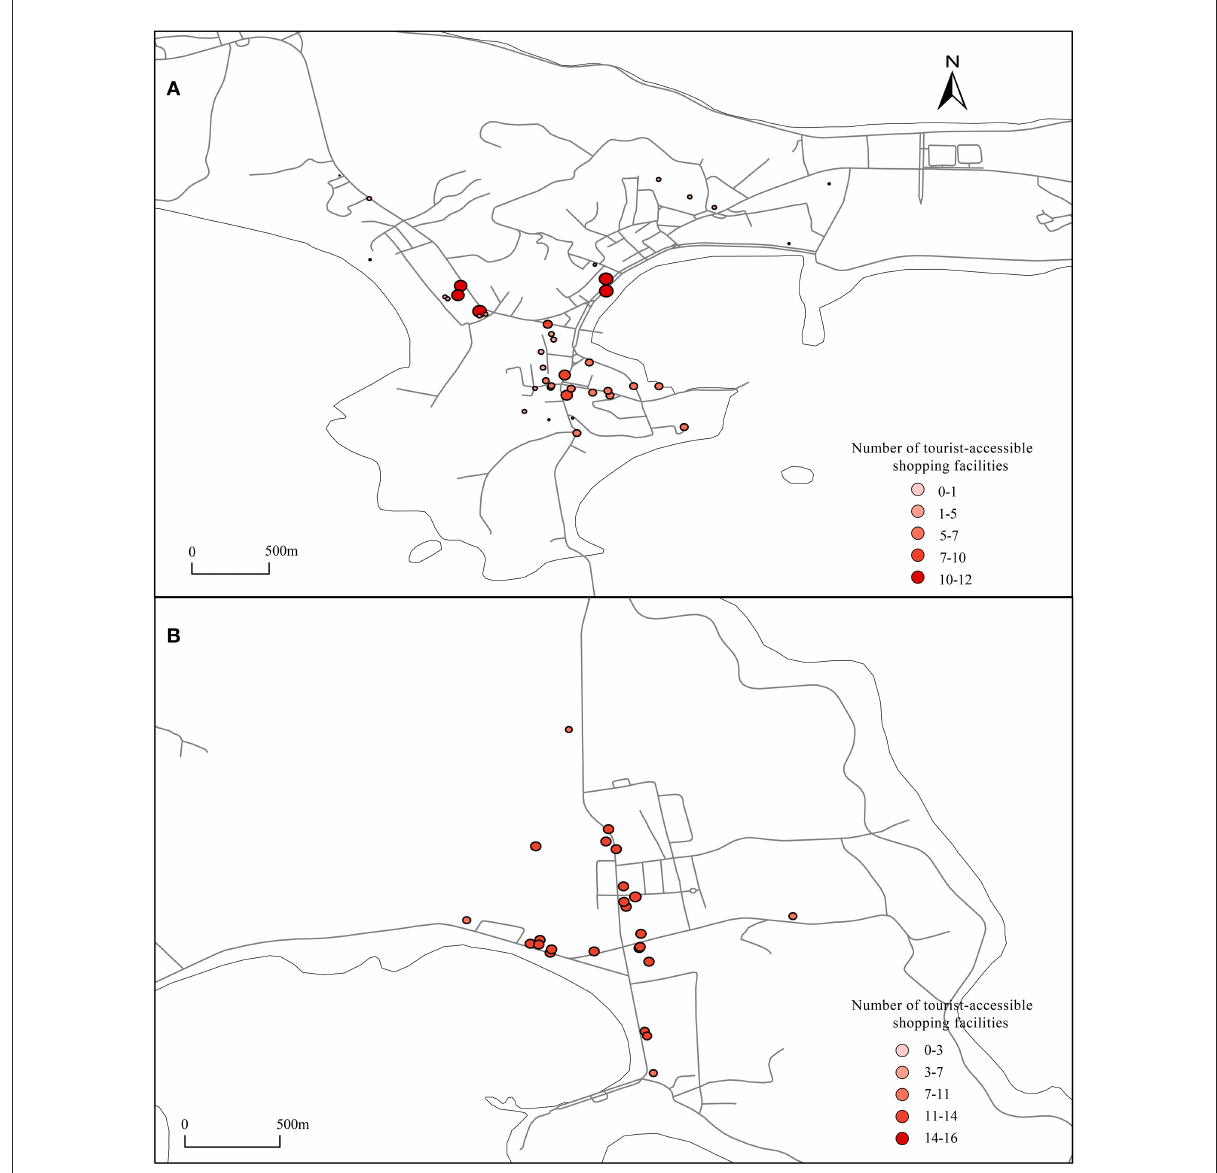
FIGURE8 Shopping facilities accessible to tourists. (A, B) Using the UNA analysis tool, set the tourist accommodation facilities as the starting point, shopping facilities as the ending point, import the road network, and calculate the number of shopping facilities that can be reached from tourist accommodations within a range of 800